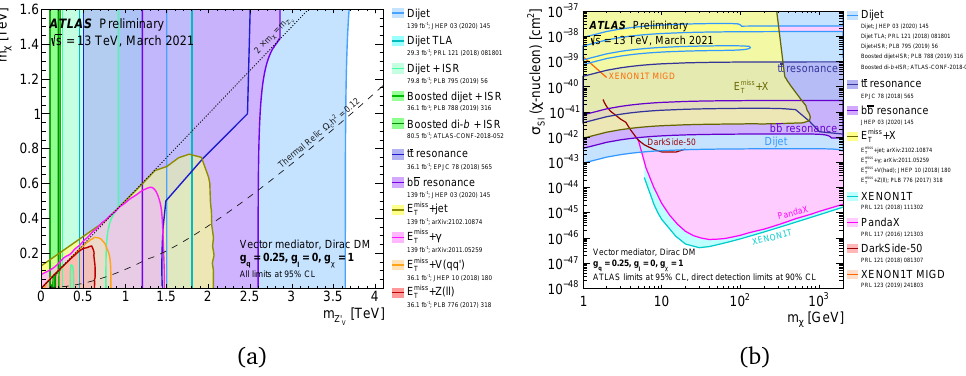
Figure 2: (a) Results on benchmark simplified DM model including a vector me- diator and fermionic WIMPs. (b) Comparison of ATLAS results to direct-detection DM experiments in the case of a spin-independent interaction between WIMPs and nucleons. Figures from [ 8 ]